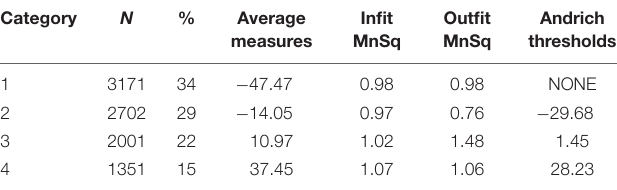
TABLE 3 | Category